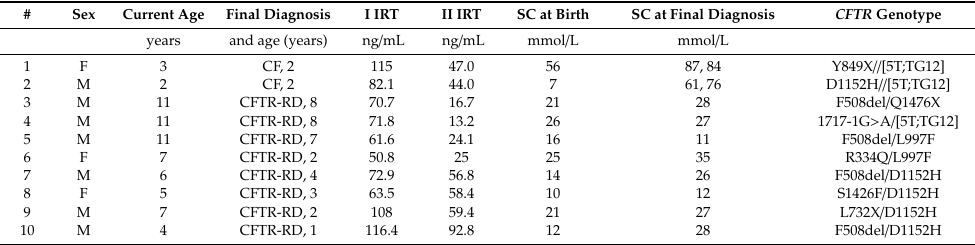
Table 5. Data of newborn screening of 8 subjects with CF-SPID evolved to CF (cases 1 and 2) or to CFTR-RD (cases 3 to